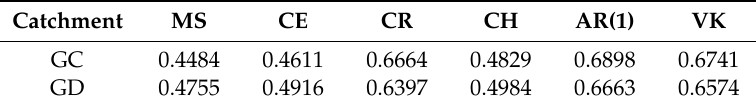
Table 4. Baseflow index (BFI) of the GC and GD catchments calculated using the six different baseflow recession constant estimation methods.